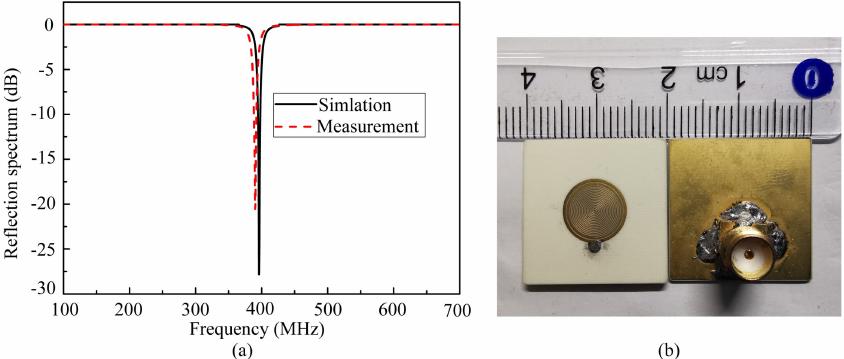
Figure 4. ( a ) The simulated and measured results of the proposed probe without materials under test. ( b ) The picture of the proposed probe.